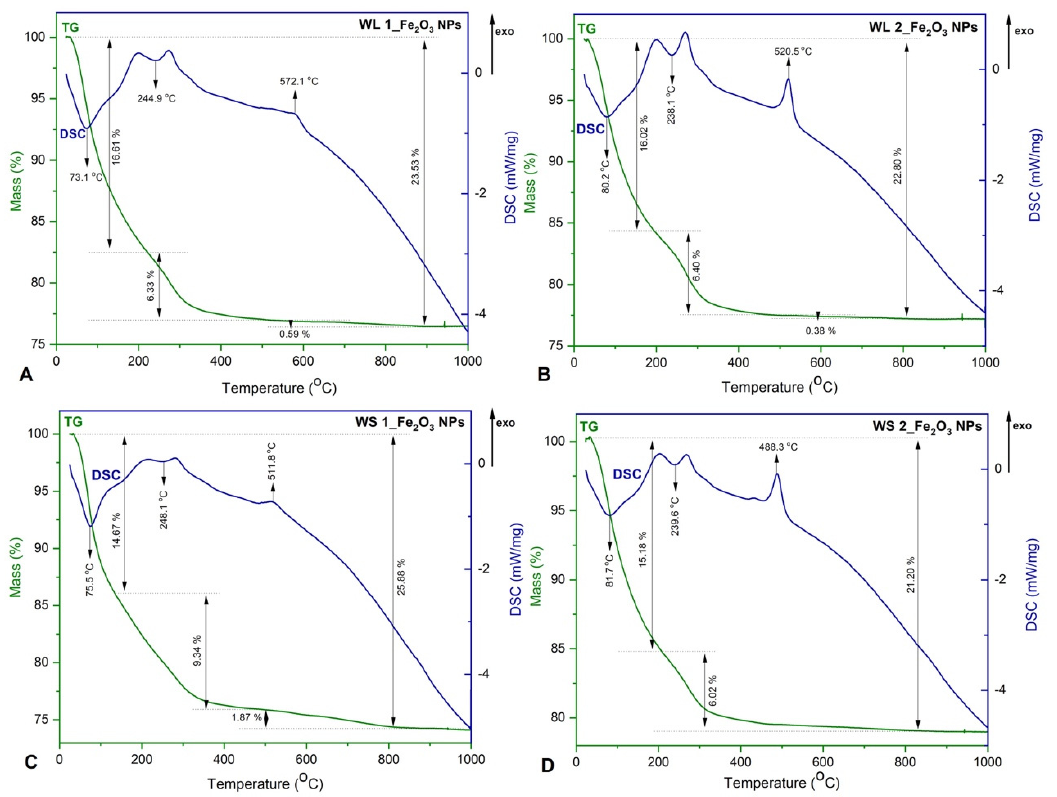
Figure 3. TG − DSC curves IONPs obtained by green synthesis; ( A ) Fe 2 O 3 NPs from WL aqueous extract at 80 °C, ( B ) Fe 2 O 3 NPs from WL aqueous extract at 25 °C, ( C ) Fe 2 O 3 NPs from WS aqueous extract at 80 °C, ( D ) Fe 2 O 3 NPs from WS aqueous extract at 25 °C. The TG − DSC curves indicate there are no significant differences between IONPs sam- ples. The endothermic/exothermic effects recorded on all DSC curves are more intense when the precipitation was made at room temperature (25 °C) (Figure 3B,D). According to the TG analysis (Figure 3), the total weight loss percentage in all samples was about 23 ± 2%. The highest weight loss was recorded below 400 °C ( ⁓ 20%), attributed to the water molecules loss of the phytocompounds on the IONPs surface. In addition, between 200 and 300 °C the DSC curves show two overlapped exothermic effects, probably related to the oxidation of organic compounds from the plant extract. After 400 °C, on TG graphics (Figure 3A–C), the weight loss was about 1 ± 0.5%. This weight loss could be considered negligible and the phenomenon occurred is assigned to phase transformation of secondary phases obtained ( γ -Fe 2 O 3 and/or Fe 3 O 4 ) into α -Fe 2 O 3 [23,37]. At 488.3 °C a phase transformation occurs, without mass loss (Figure 3D). This phase transformation is characteristically to the transformation of γ -Fe 2 O 3 to α -Fe 2 O 3 . In addition, the reddish-brown color of IONPs could be an excellent indicator in formation of α -Fe 2 O 3 [61]. Moreover, due to the fact that on the temperature range 400–1000 °C occurs a much lower weight loss, this fact assures the complete formation of α -Fe 2 O 3 . Regarding the DSC curves, exothermic and endothermic peaks were recorded. Forasmuch as neither exother- mic effect accompanied with mass growth on TG curve, was detected, confirm that in all sample it was obtained only hematite as a majority phase and traces of maghemite. If the exothermic effect could have been detected around 200–250 °C with a growth mass, we could have said that in the samples we also had magnetite, which at this temperature oxidizes at maghemite. The exothermic effects recorded around 500 °C, without mass loss (or negligible), confirms the maghemite transition to hematite [62,63].